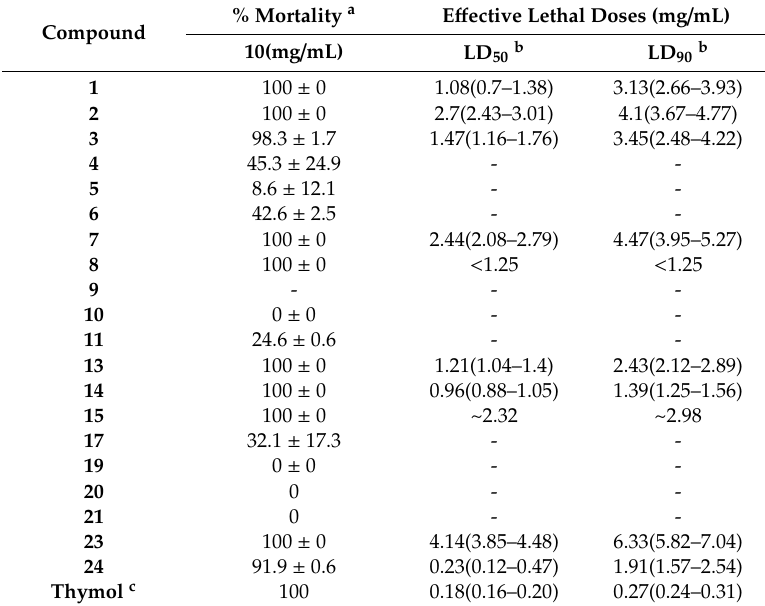
Table 2. Acaricidal activity of germacrone derivatives against a H. lusitanicum Koch. % Mortality a Compound